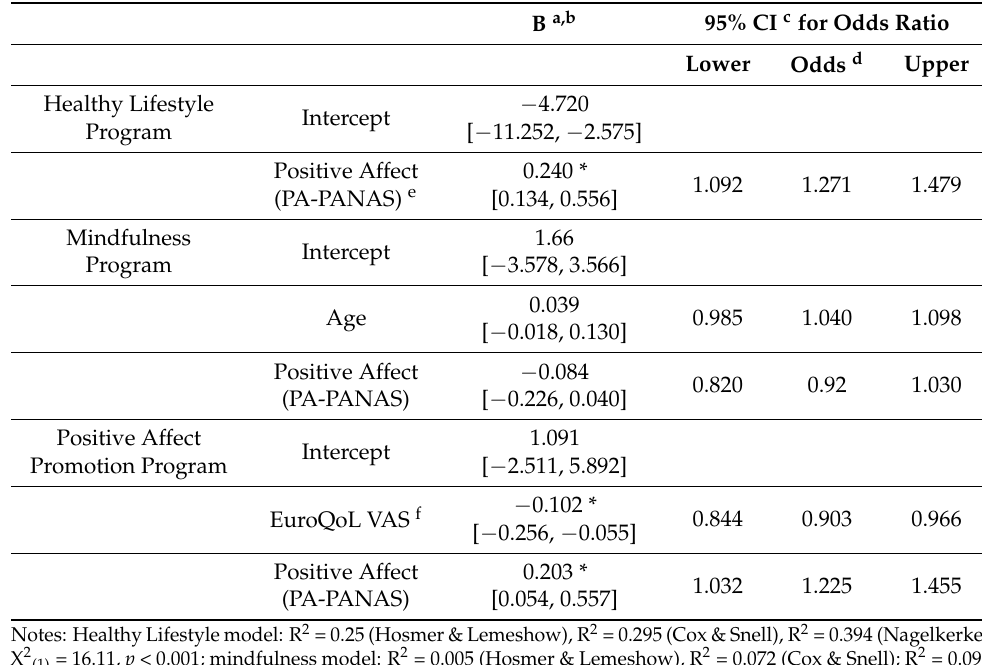
Table 3. Coefficients of the models (Model 1: Healthy Lifestyle Program; Model 2: mindfulness Program; Model 3: Positive Affect Promotion Program) predicting whether a patient was adhered to the intervention.